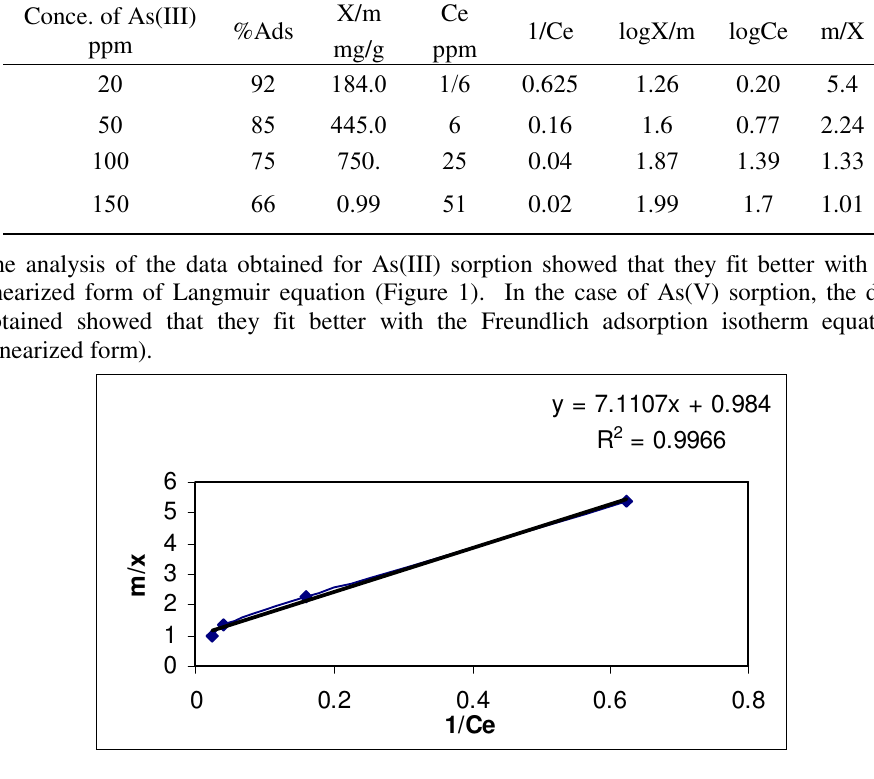
Figure 1 Adsorption isotherm obtained form As(III) sorption by AC using Langmuir equation (linearised